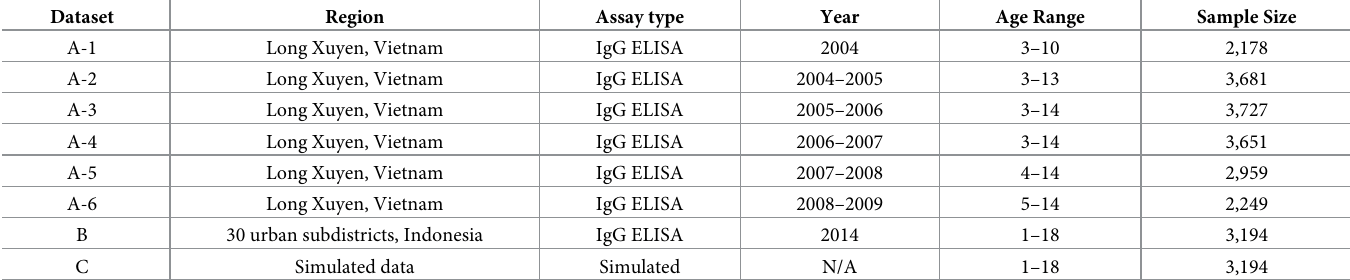
Table 1. Description of the datasets used in the analyses. Summary statistics including notation, region, the assay used, the year of testing, the age range of the children participating to the study and the sample sizes.